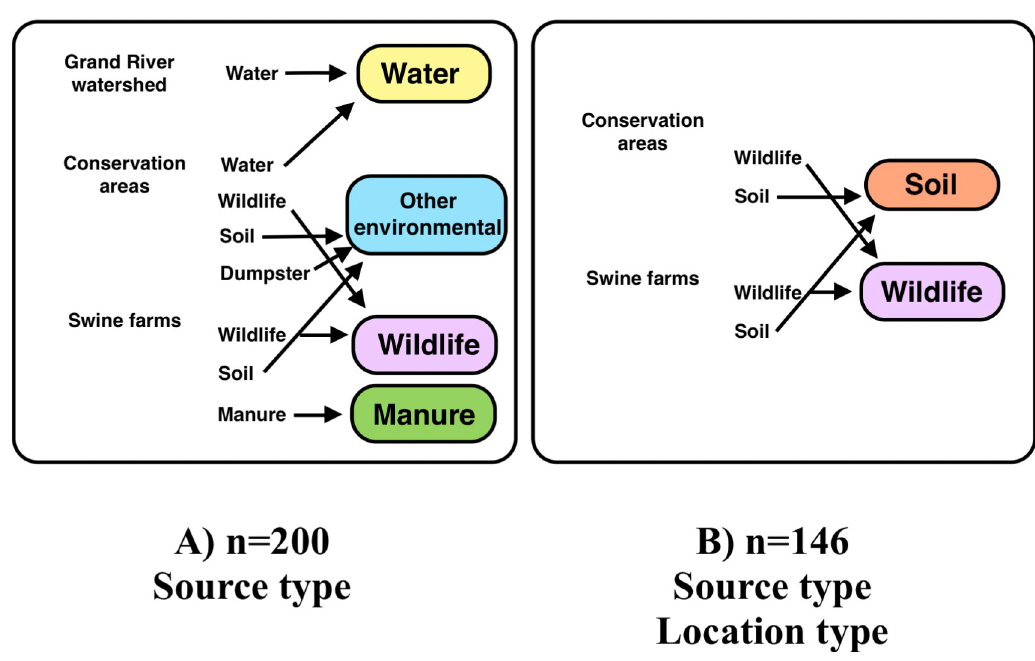
Fig 1. Classification of source types for overall dataset (A), and subset of data (B), with sample sizes and independent variables analysed of Escherichia coli isolates collected in southern Ontario, 2011 − 2013.